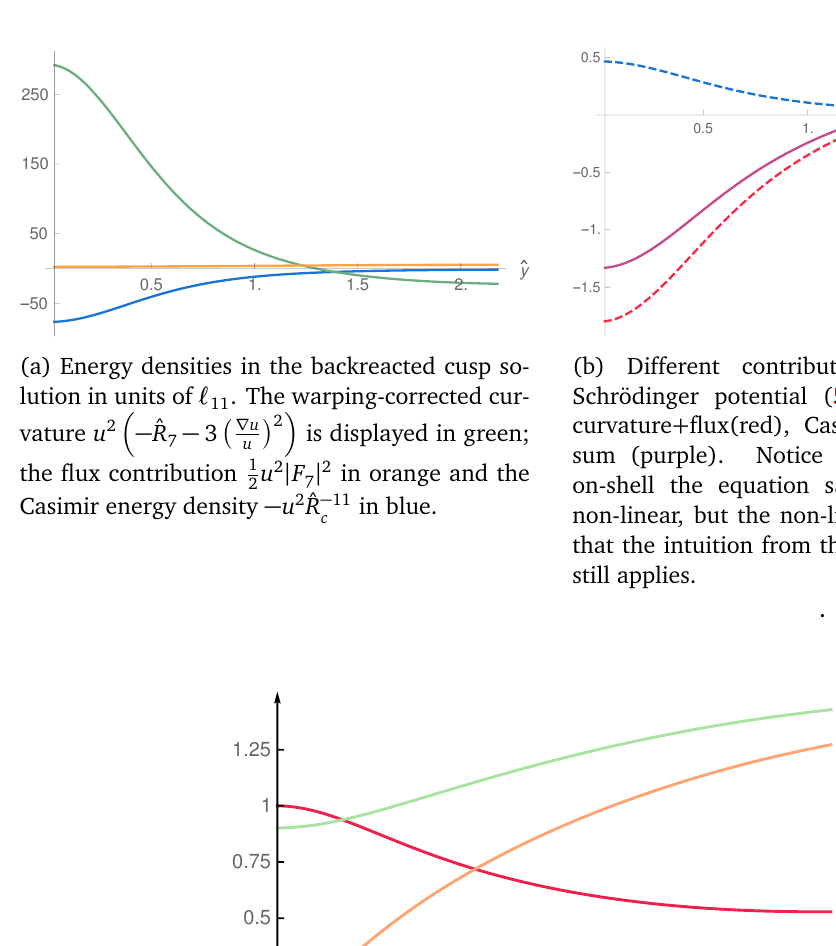
Figure 6: A numerical solution of the equations of motion in the cusp region. At ˆ y = 0, the function ˆ R (orange) goes to zero linearly, with the circle parametrized by the coordinate θ shrinking smoothly. At the same point, both e 2 A (red, rescaled with e − 2 a 0 ) and ˆ R (green), reach a finite value, in agreement with the expansion (5.67). c On the right, the solution is glued to the bulk of the manifold, as discussed in the main text. Panel (a) and (b) show the backreacted energy densities and contributions to the u equation of motion respectively. This numerical solution is obtained for = e 2 = e − c 150. For clarity we are displaying it for a small c c 0.65, ˆ f c = 2.2, r 11 c 0 0